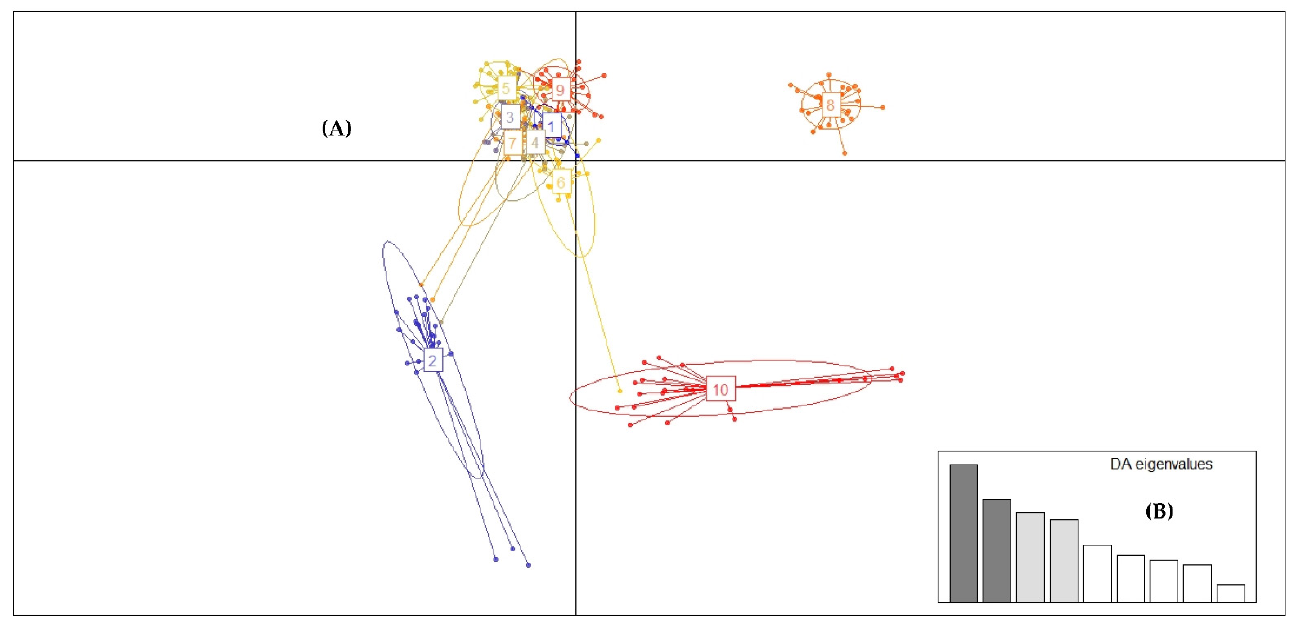
Figure 10. Analysis of the population genetic structure of G. avellana using discriminant analysis of principal components (DAPC) based on EST-SSR data. ( A ) Graph shows the formation of ten genetic groups. ( B ) Discriminant analysis eigenvalues. The bar plot of eigenvalues retains 40 PCs that explain over 80% of the cumulative